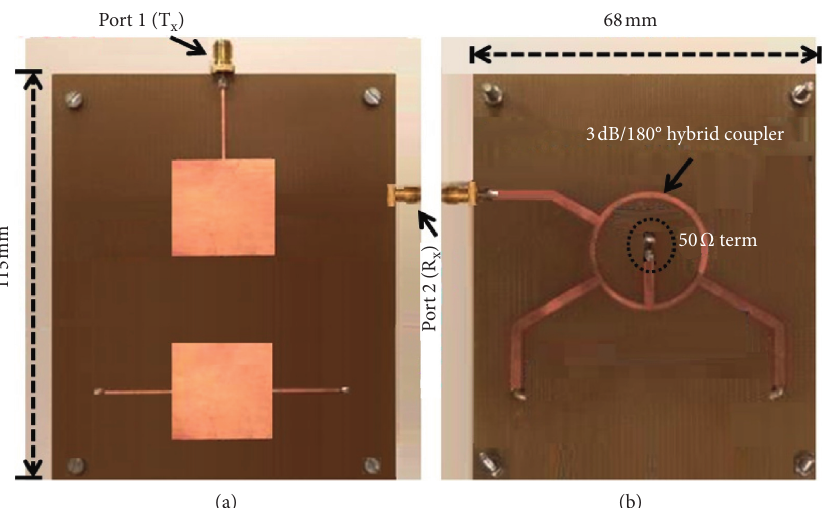
Figure 6: The validation model (prototype) of 2.4GHz differential fed IBFD bistatic patch antenna implemented on double layered FR-4 substrate. (a) Top side. (b) Bottom